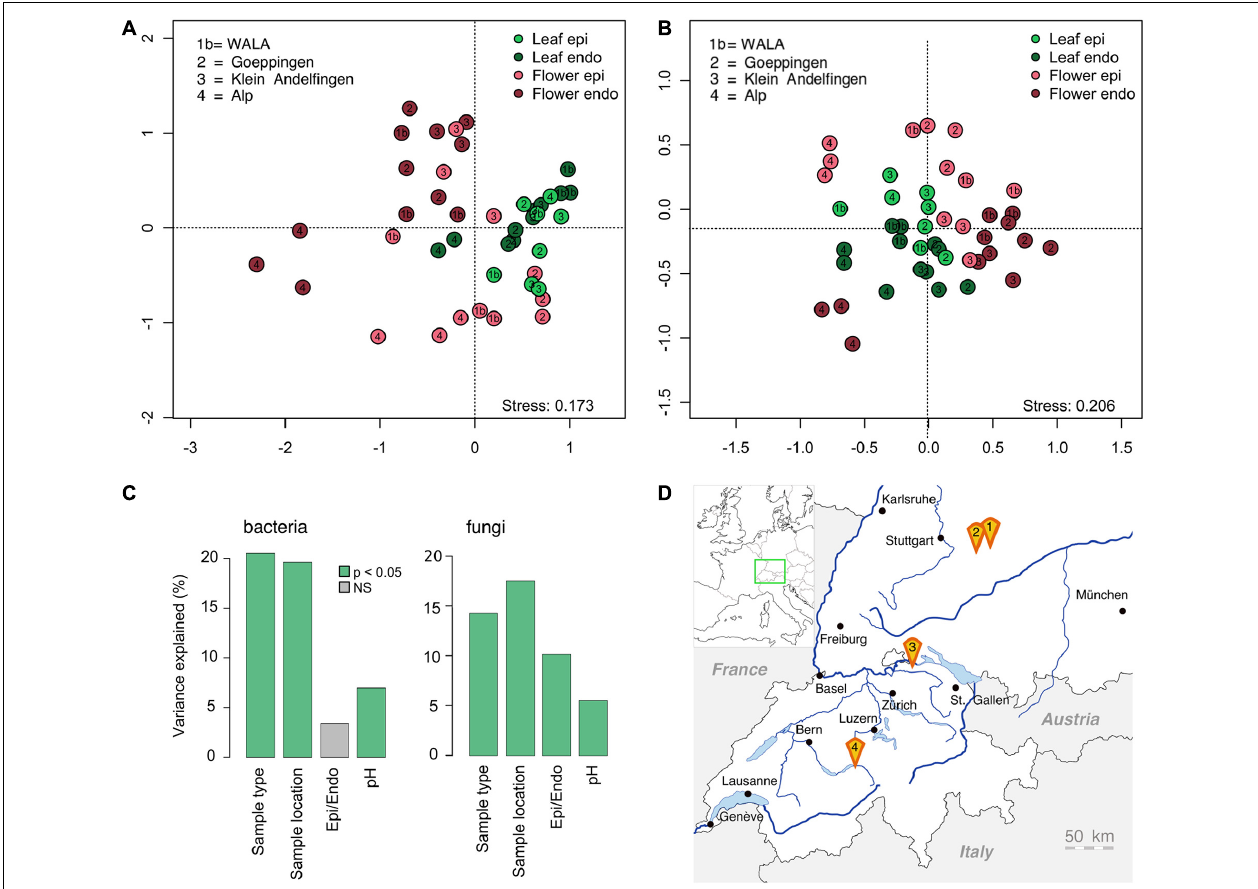
FIGURE 8 | Graph of the NMDS analysis of the bacterial [ (A) ; n = 43] and fungal epi- and endophytic leaf and flower communities [ (B) , n = 44] of Achillea at four different locations in southern Germany and Switzerland (D) . For details of locations see Table 1 . (C) PERMANOVA ( p < 0.05) including sample type (leaf/flower), location, epi- and endophytic compartment and soil pH of each